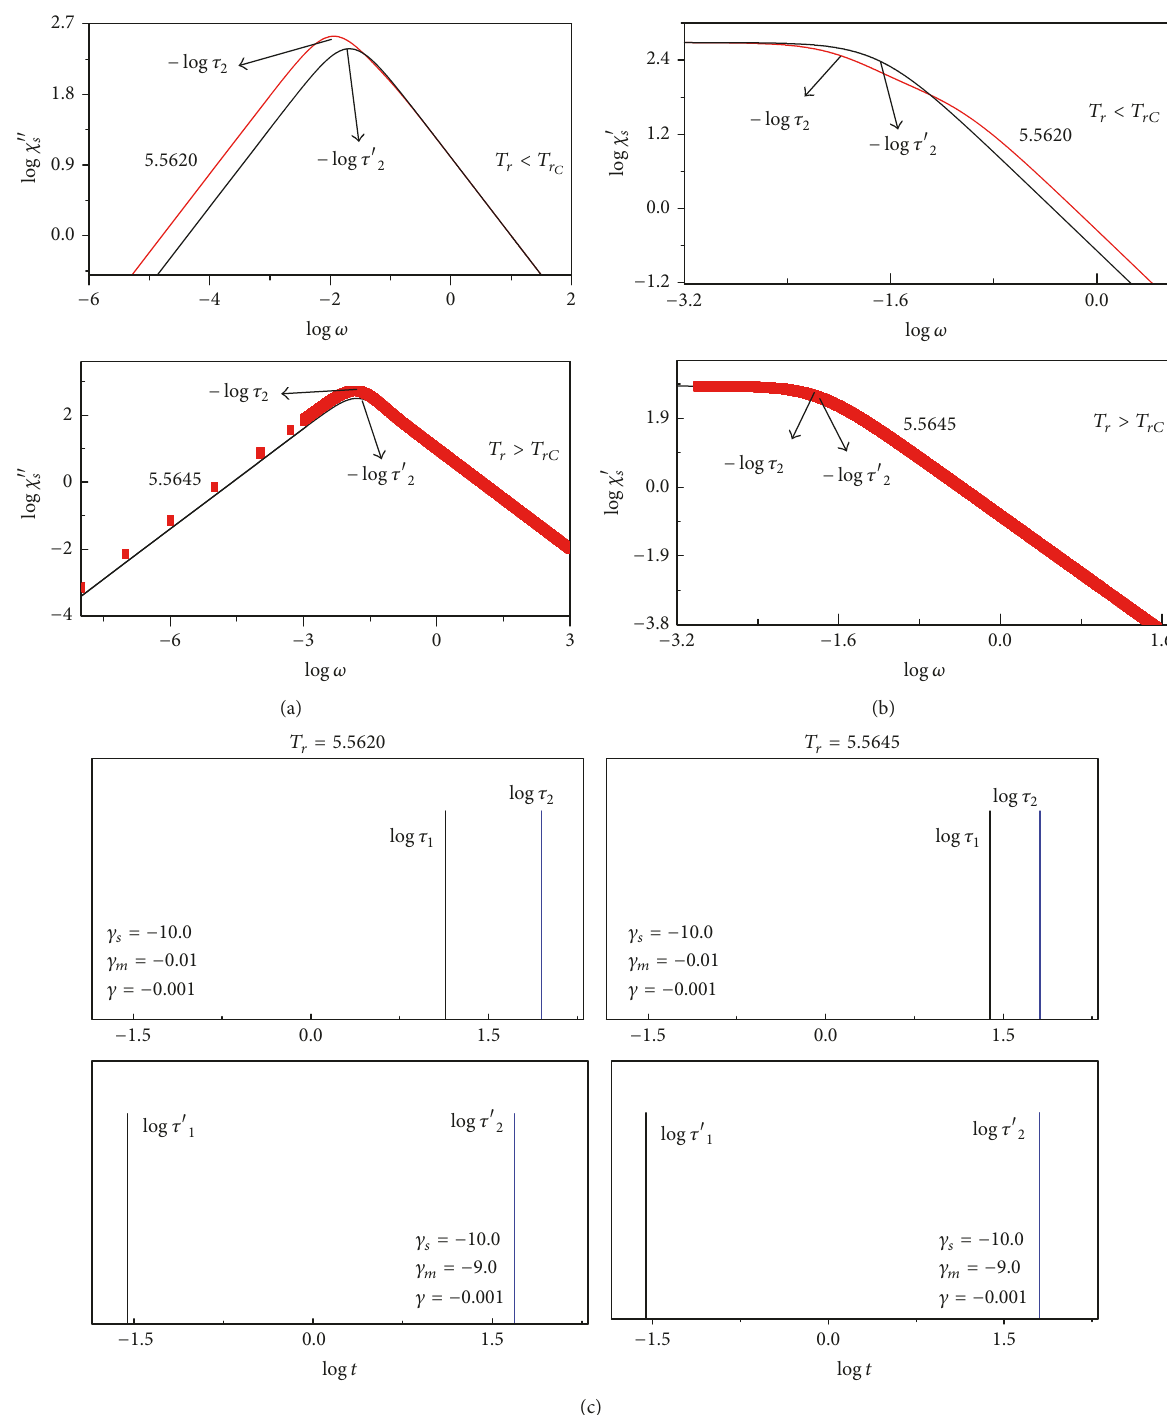
Figure 3: Same as Figures 2(a)–2(c) but for two distinct temperatures in the neighborhood of the critical temperature.